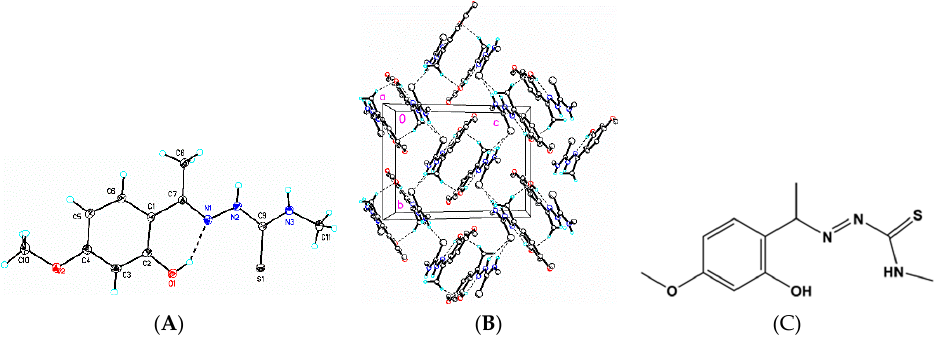
Additional weak and C–H … O intermolecular interactions (Table 4) assist in linking the molecules into dimers along (010) and influence crystal packing (Figure 4). into dimers along (010) and influence crystal packing (Figure 4).